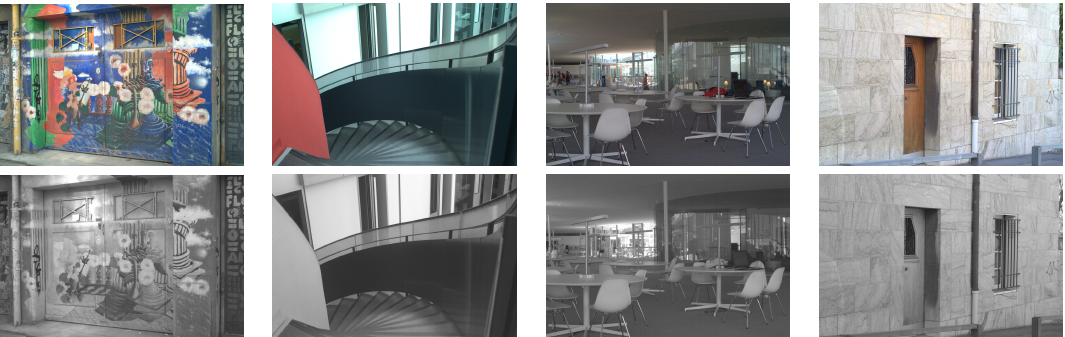
Figure 7. Four pairs of images from the subset used for validation: ( Top ) Visible spectrum images; ( Bottom ) NIR